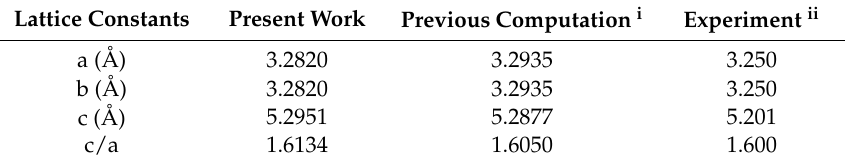
Table 1. Calculated and experimental values of the structural parameters for bulk ZnO unit cell. a, b, and c are the lattice parameters. Lattice